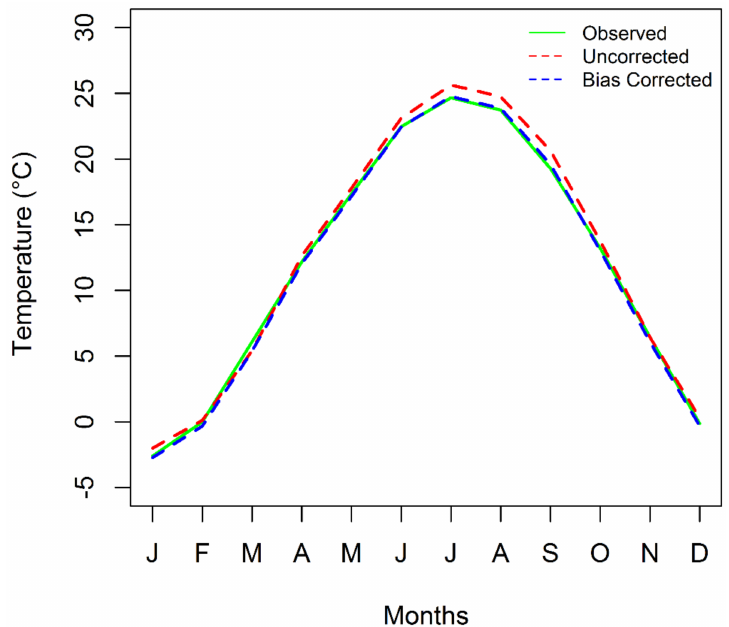
Figure 4. Monthly temperature ( ◦ C) over Goodwater Creek Experimental Watershed for the period of 1971–2010. Results are shown for the observations, the uncorrected, and bias-corrected RCP4.5